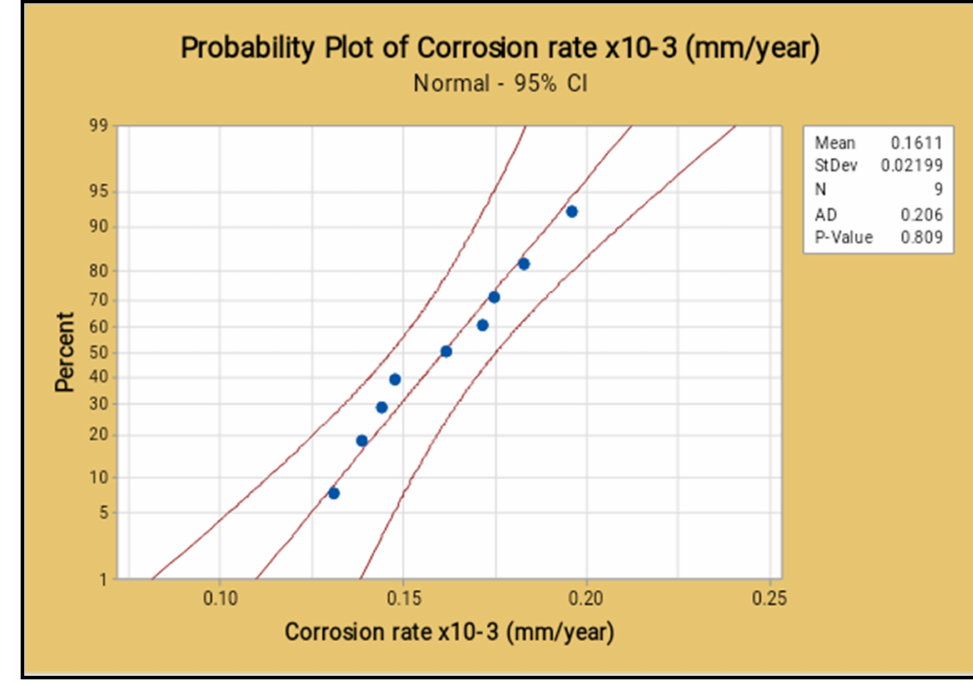
Figure 24. Probability plot for corrosion